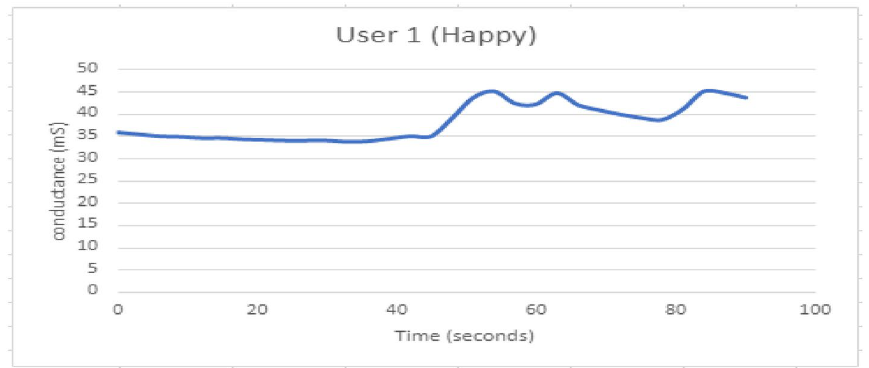
Fig. 15 GSR response when participant 1 is Happy